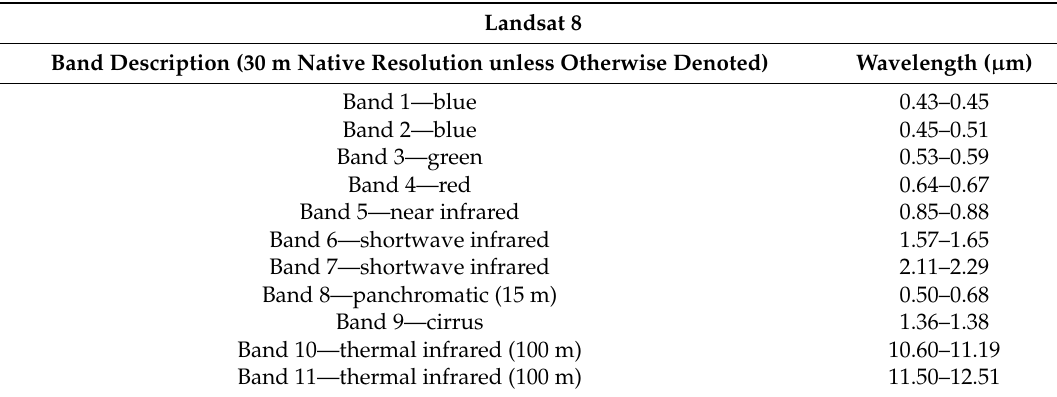
Table 1. Specification of Landsat 8